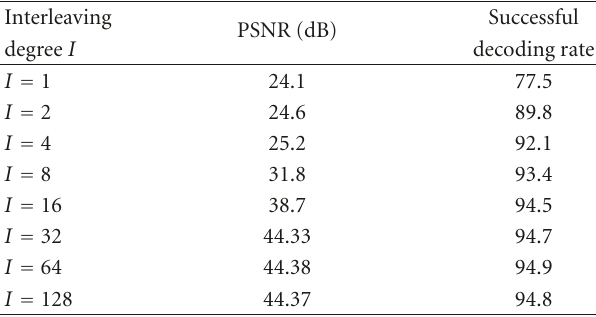
Table 1: Interleaving degree and associated image